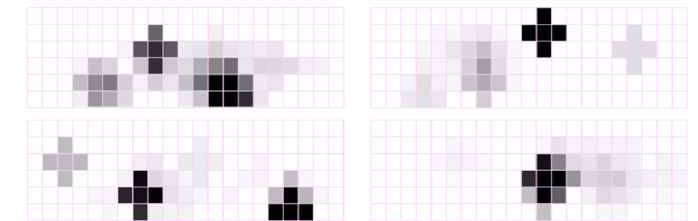
Figure 9. Protrusion map from histograms.